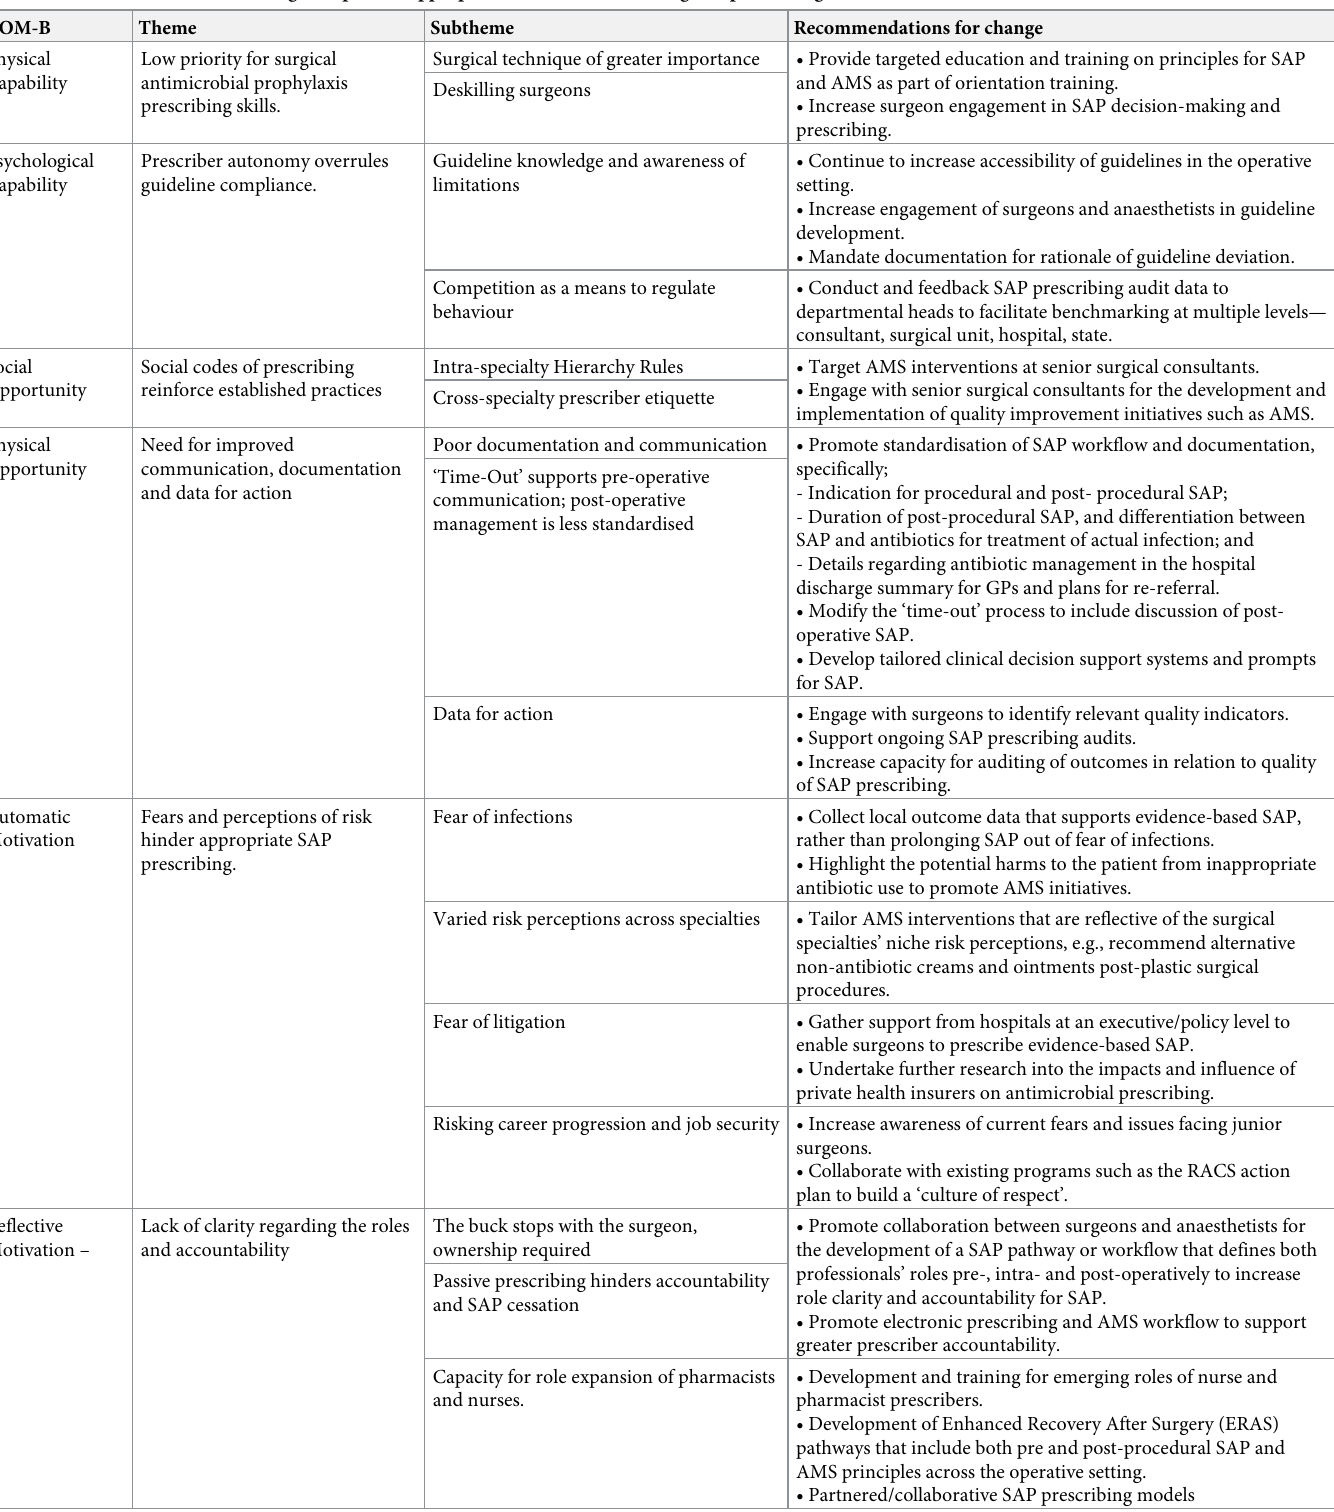
Table 9. Recommendations for change to optimise appropriate SAP decision-making and